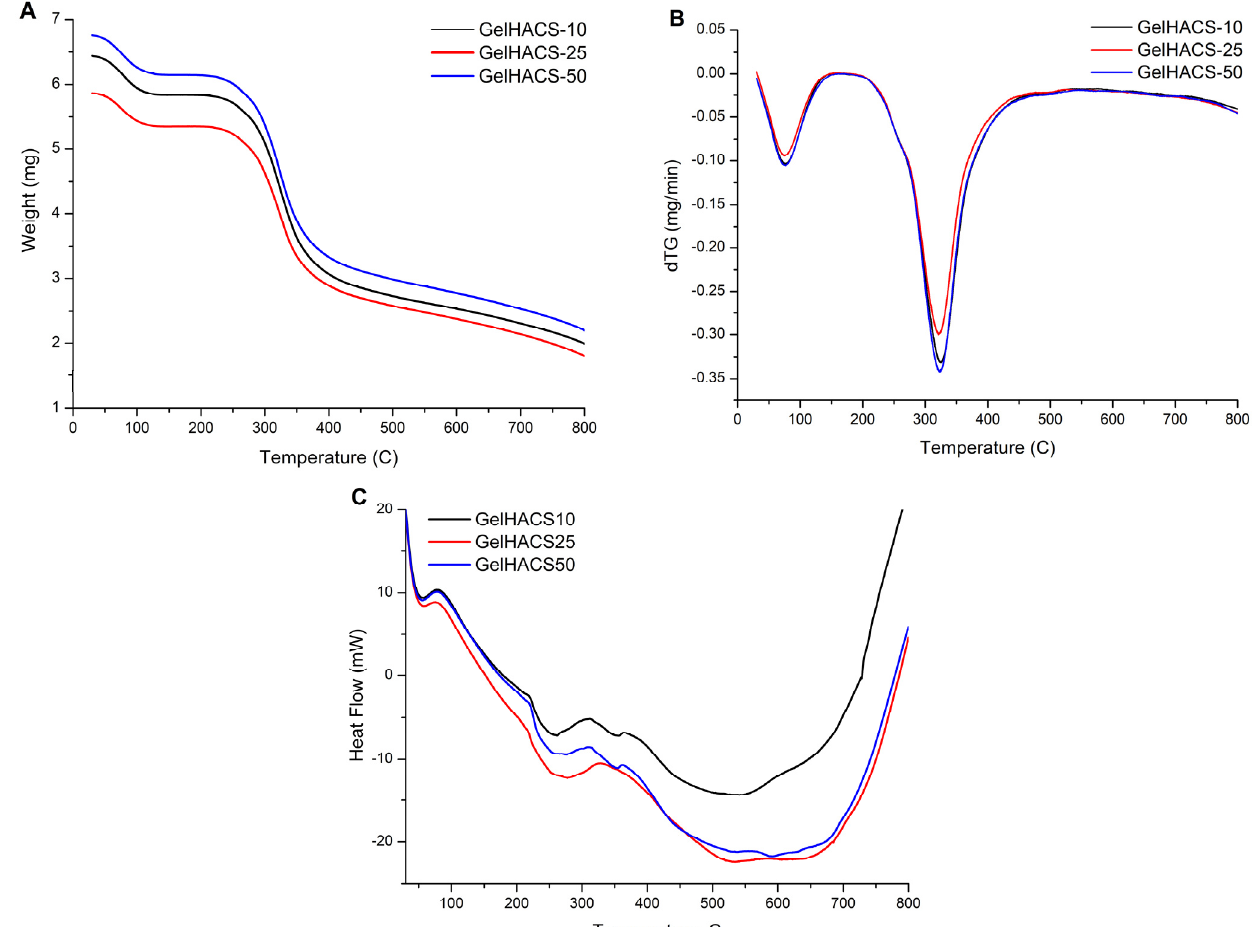
Figure 6. TG ( A ), dTG ( B ) and DSC ( C ) curves of synthesized cryogels.